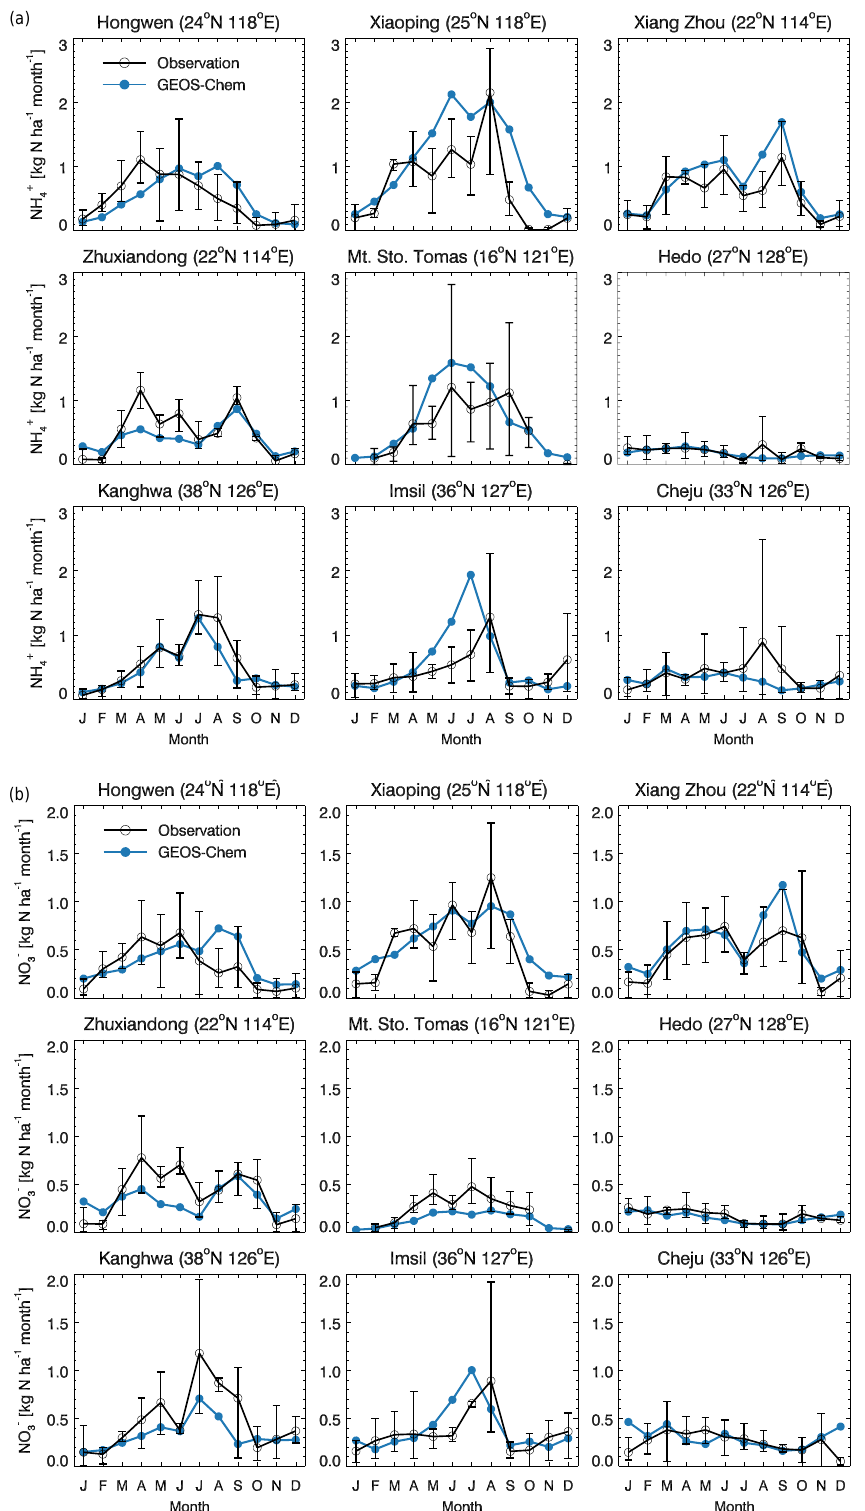
Figure 6. Monthly averaged ammonium (a) and nitrate (b) wet deposition fluxes at nine EANET coastal sites (Fig. 5). The black lines are 3-year averages (2008–2010) of observations, and the blue lines are the corresponding model results. The vertical black lines represent the range of observed values for